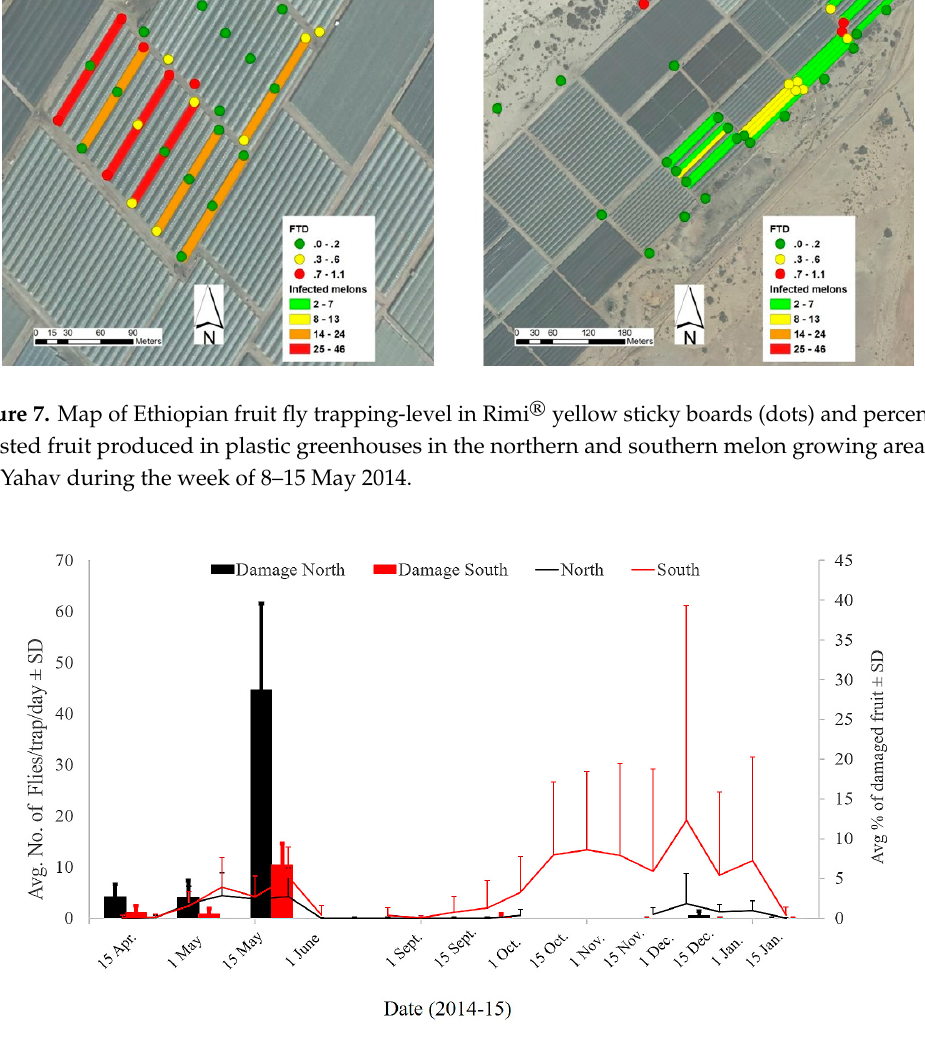
Figure 8. Average Ethiopian fruit fly trapping level in yellow sticky boards in the northern and southern melon growing areas of Ein Yahav, throughout 2014 and early 2015, and percent of fruit infestation.